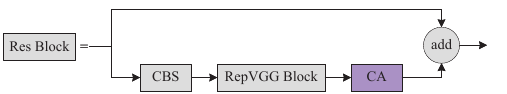
Figure 3. Embedding coordinate attention to the Res